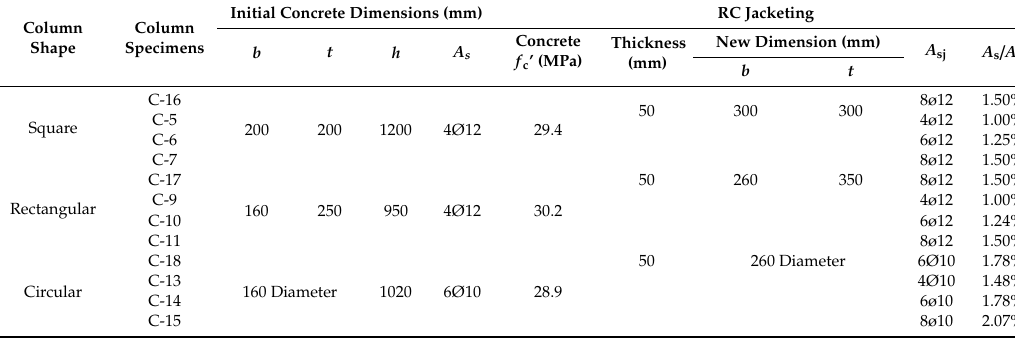
Figure 3. Details of the circular RC columns strengthened by complete RC jacketing. Table 2. Properties of the RC column specimens strengthened by complete RC jacketing .